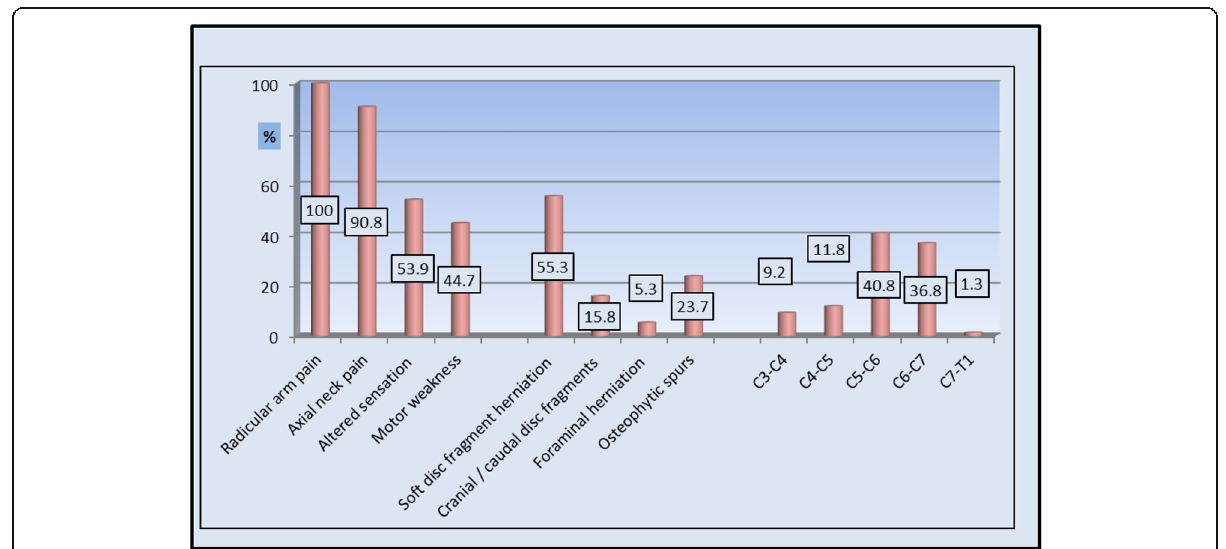
Fig. 4 Clinical symptoms attributable to different pathologies at disc levels